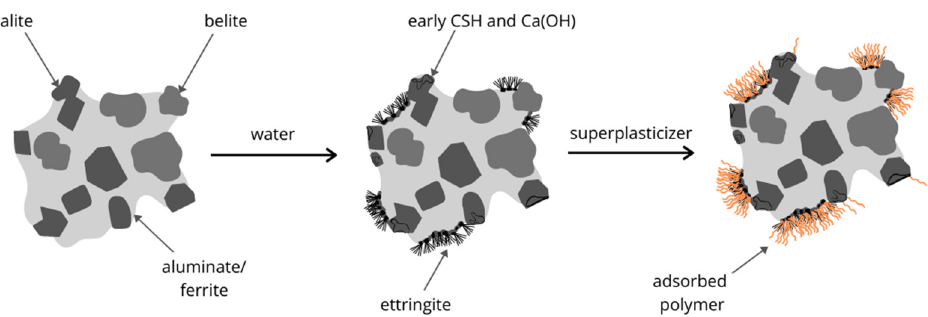
Figure 3. The scheme of a hydrating cement grain with uneven superplasticizer polymer distribution on its surface (adapted from [67]).